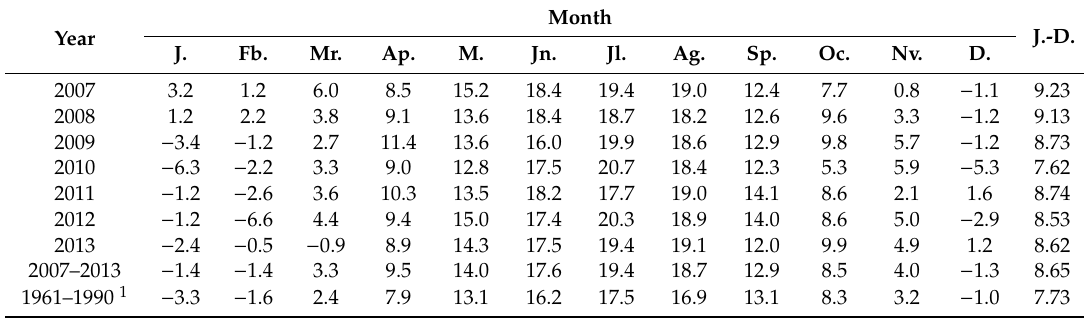
Table 1. Mean temperatures ( ◦ C) during the course of study.